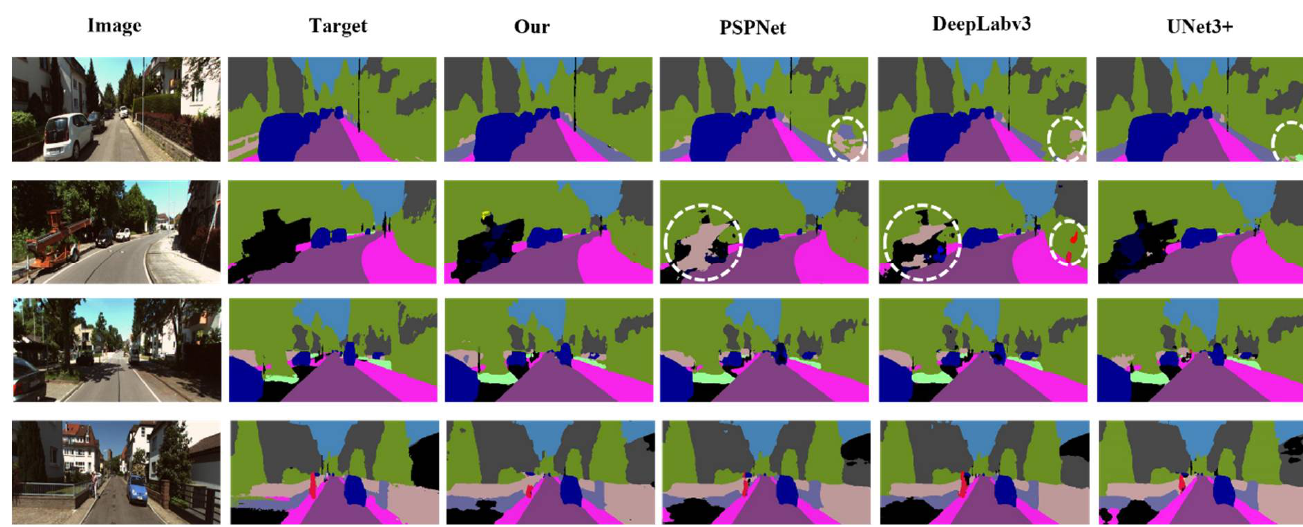
Figure 18. Visualization results on KITT-360 (including complex class). Table 7. Performance comparison of each model on the Cityscape